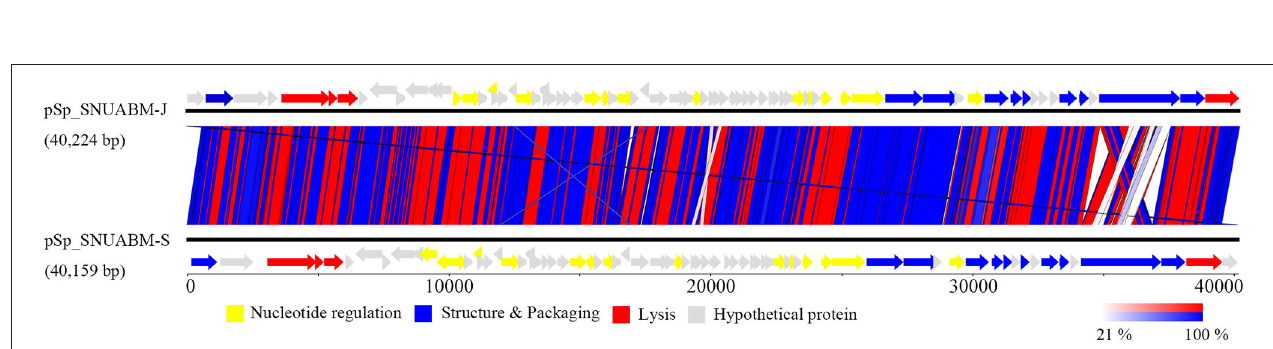
FIGURE 7 | The whole genome map of the phage pSp-J, and pSp-S. Predicted ORFs are classified according to their function; yellow represents nucleotide metabolism related proteins, blue represents structural and packaging related proteins, red represents lysis related proteins, and gray represents hypothetical proteins. (Scale = base